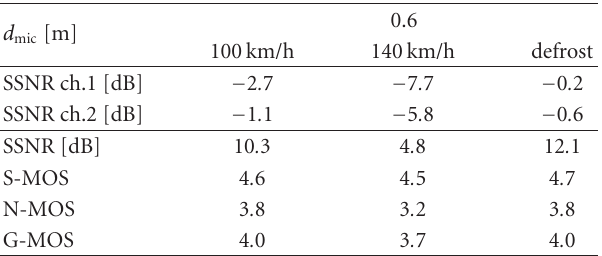
Table 2: Simulation results for the proposed system in the car environment, cf. results on the right of Table 1.